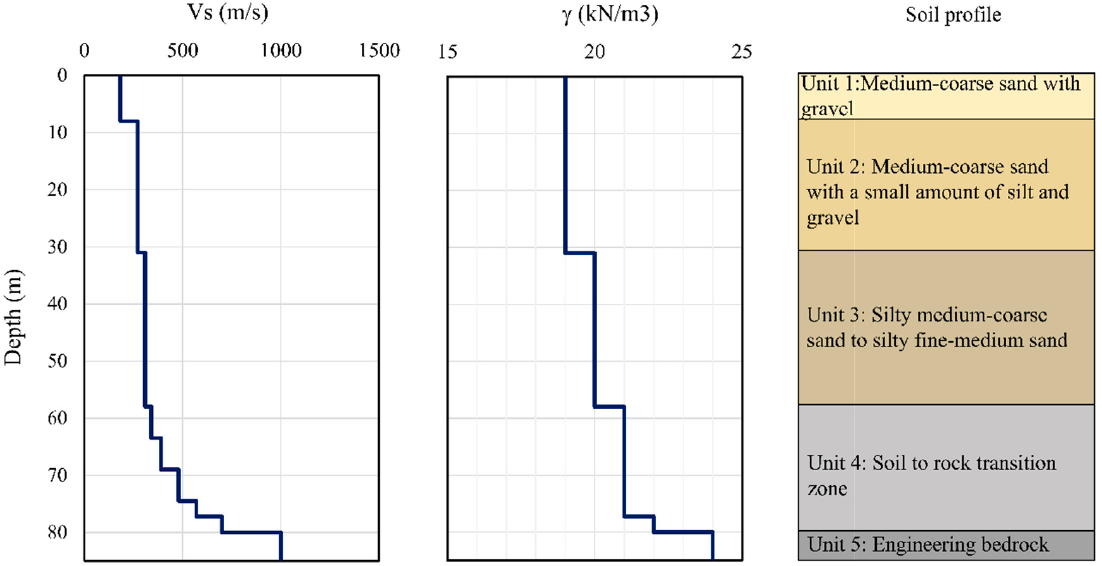
Figure 3. Lithostratigraphic layers and geotechnical properties of the study area. Left: shear wave velocity (m/s). Centre: saturated unit weight (kN/m 3 ). Right: soil profile.